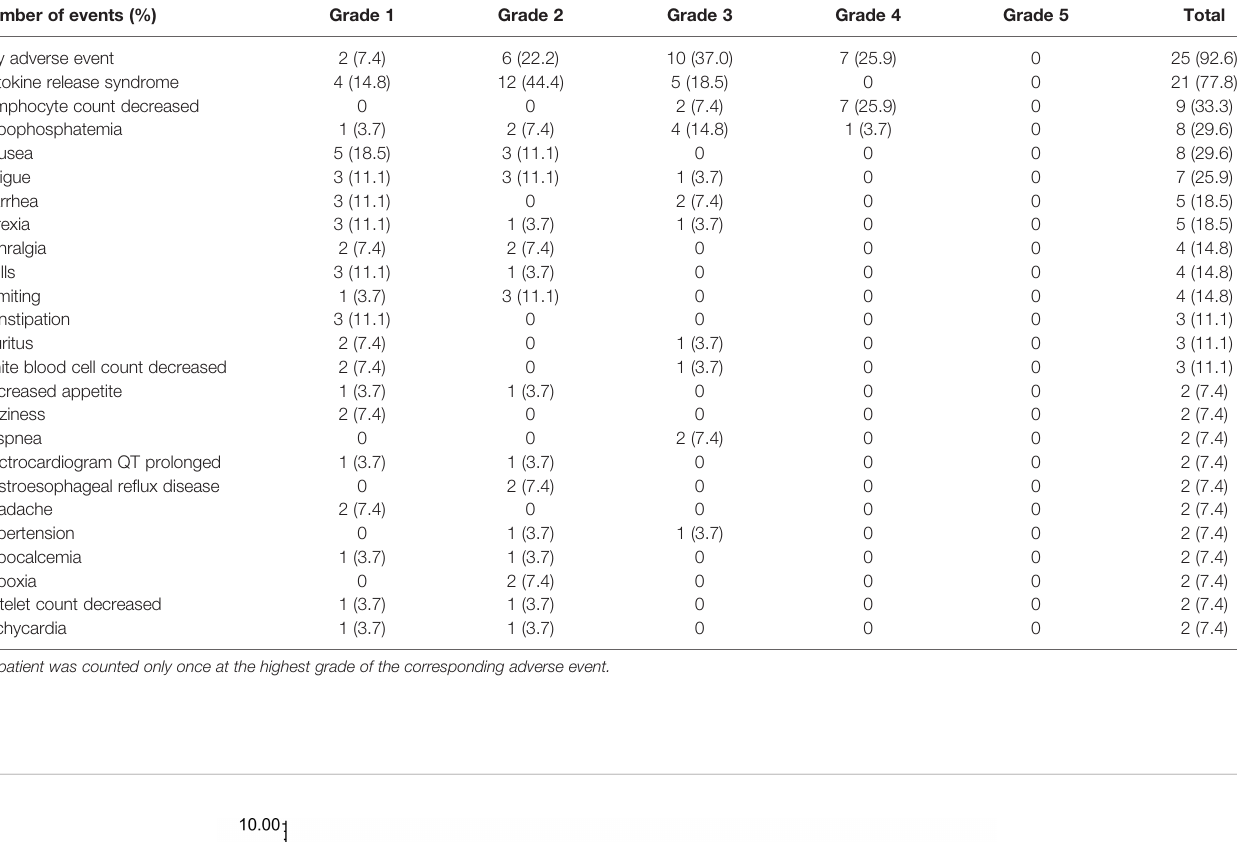
TABLE 2 | Treatment-related adverse events reported in ≥ 5% of patients ( N = 27) a . Number of events (%)